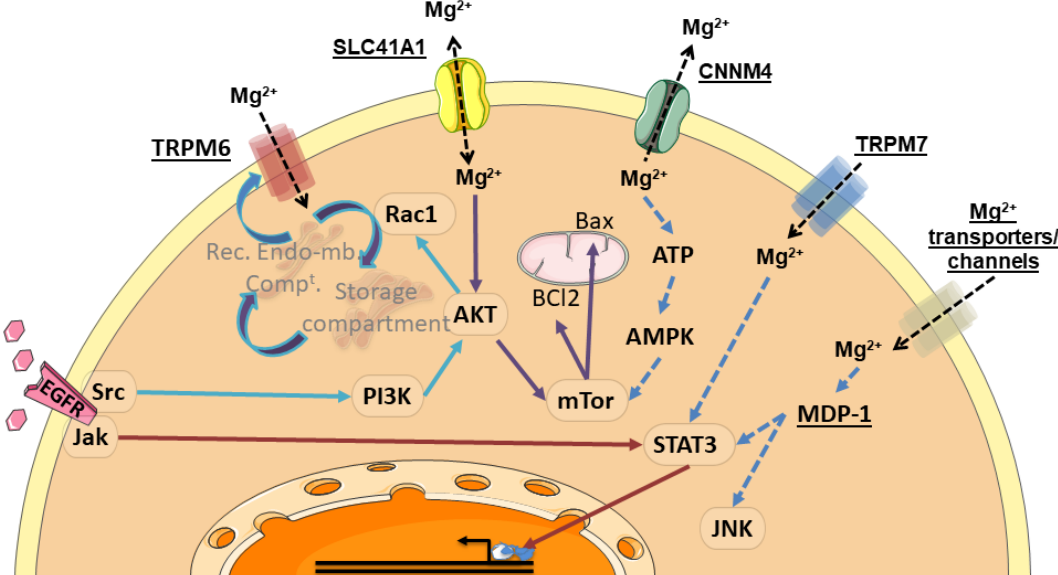
Figure 6. Summary of signaling pathways associated with Mg 2+ transporters . Mg 2+ transporter, channels and Mg 2+ -dependent proteins are underlined. These proteins activate kinases, signaling proteins and/or transcription factors (framed in ovals). As a result, some processes, such as protein redistribution to the plasma membrane, control of effector proteins and transcriptional regulation can occur. Rec. Endo-mb. Comp t .: recycling endomembrane compartment. Mg 2+ , Magnesium; EGFR, Epidermal Growth Factor Receptor; TRPM6, Transient Receptor Potential Cation Channel Subfamily M, Member 6; TRPM7, Transient Receptor Potential Cation Channel Subfamily M, Member 7; SLC41A1, Solute Carrier Family 41, Member 1; CNNM4, Cyclin and CBS Domain Divalent Metal Cation Transport Mediator 4; Jak, Janus Kinase; Src, Src Proto-Oncogene; PI3K, Phosphatidylinositol-4,5-Biphosphate 3-Kinase; AKT, AKT Serine/Threonine Kinase; Rac1, Rac-Family Small GTPase 1; mTor, Mechanistic Target of Rapamycin Kinase; BCl2, BCL2 Apoptosis Regulator; Bax, BCL2 Associated X Apoptosis Regulator; ATP, Adenosine Tri-Phosphate; AMPK, AMP-Activated Protein Kinase, STAT3, Signal Transducer And Activator Of Transcription 3; MDP-1, Magnesium-Dependent Phosphatase-1; JNK, c-Jun N -terminal